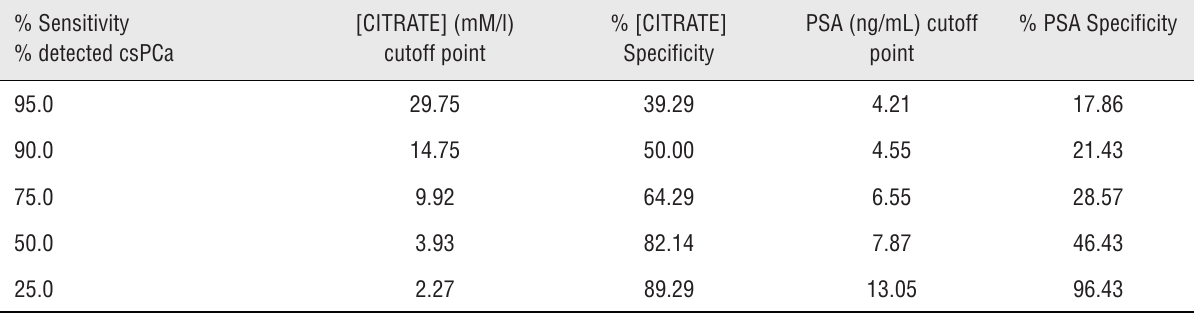
Table 3 - Specificity and cutoff points of [CITRATE] and PSA for arbitrary values of sensitivity relative to detection of csPCa. % Sensitivity % detected